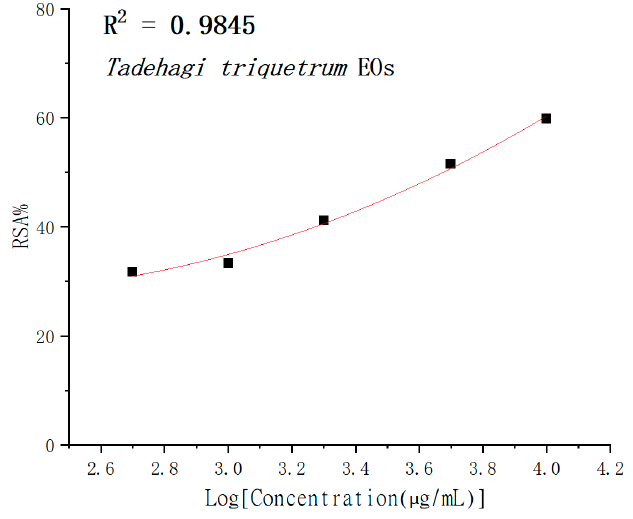
Figure 4. The percentage of free radical scavenging of T. triquetrum essential oils in DPPH assay.